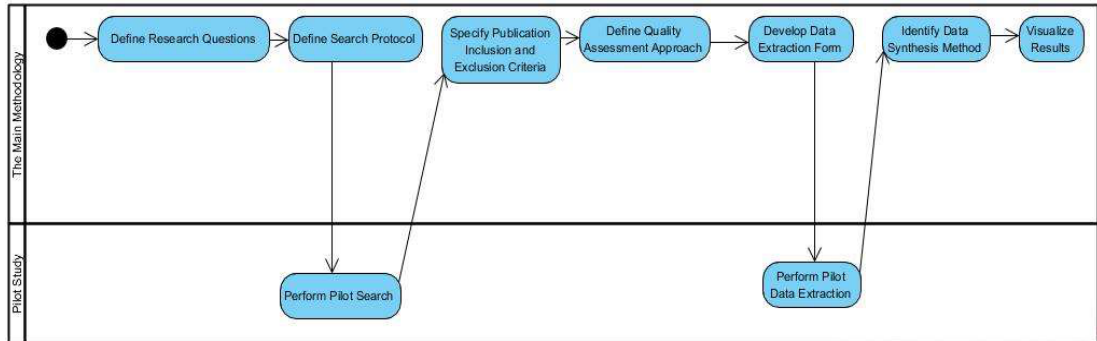
Figure 3. Methodology flowchart.